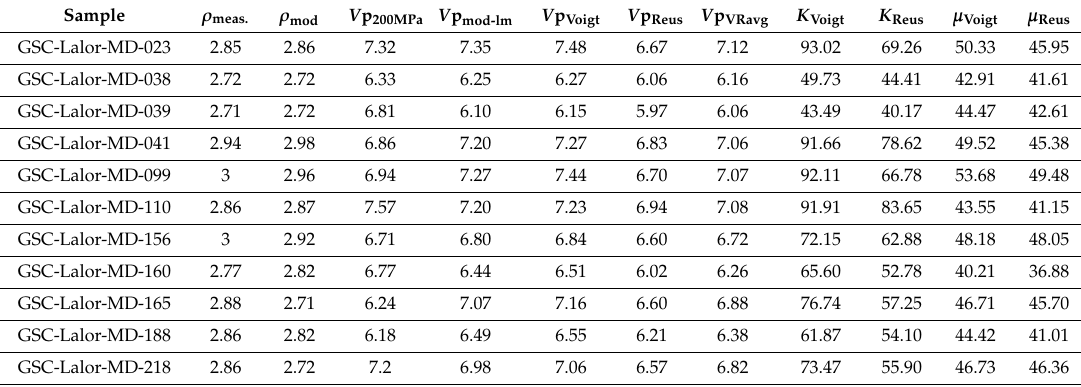
Table 5. Measured and modeled seismic rock properties.